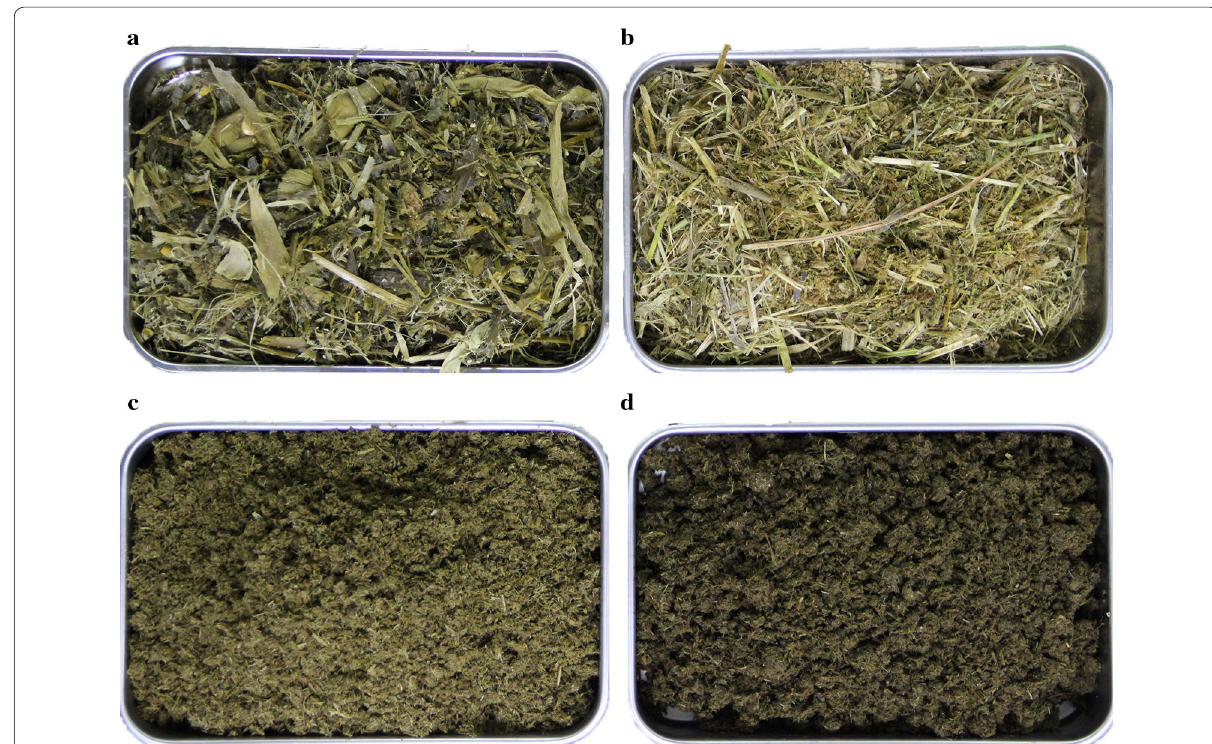
Fig. 1 Images for corn silage diets and cow manure and anaerobically digested cow manure. Corn silage diets ( a ), the coarse milled corn silage diets supplemented with additional protein feed ( b ), solid cow manure materials after removing the liquid part by mechanical packing ( c ),